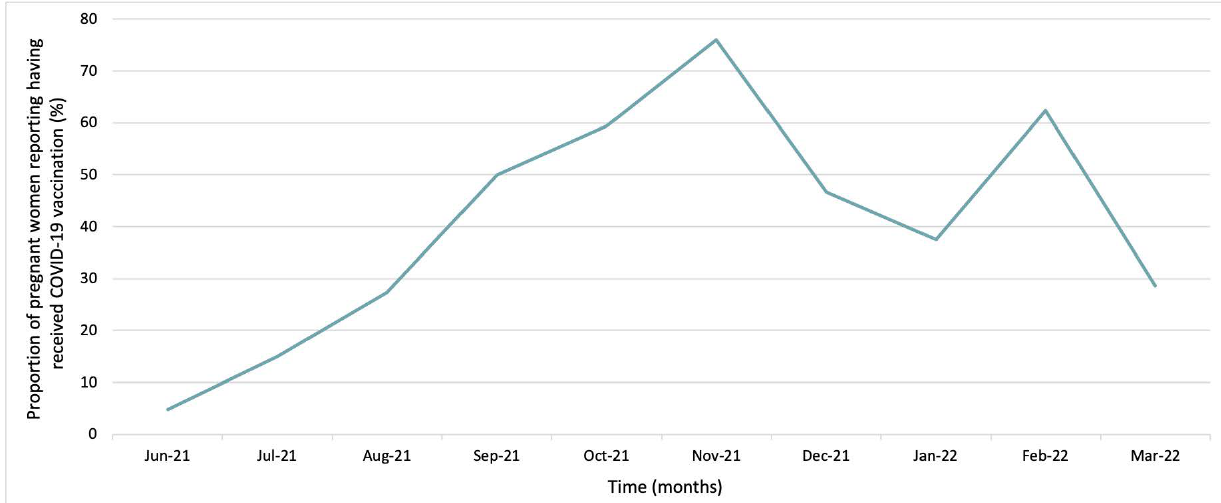
Figure 2. Trends of COVID-19 maternal vaccination uptake after the introduction of national recommendation.